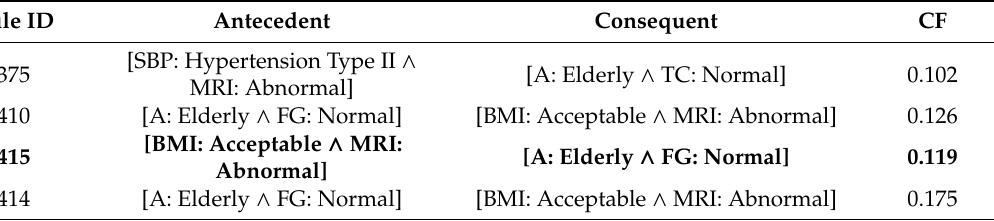
Table 9. Example result of direct-circular type